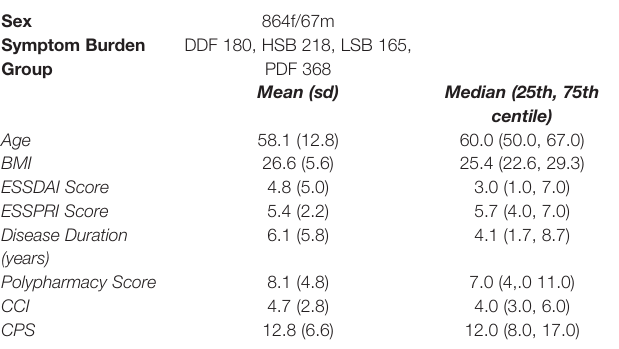
TABLE 1.1 | Cohort characteristics: a summary of key demographic and clinical data for 931 PSS participants at time of recruitment.